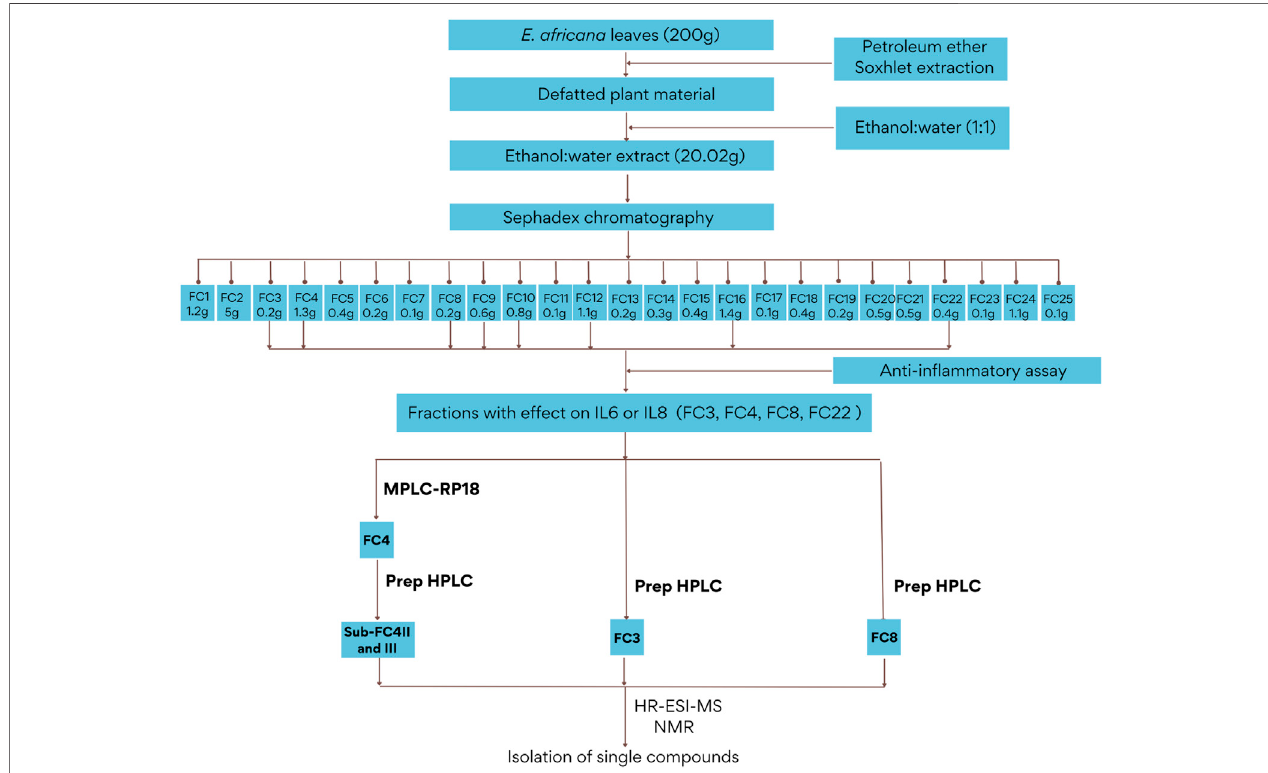
FIGURE 1 | Isolation pattern for compounds 1 – 11 from Entada africana leaves extract.